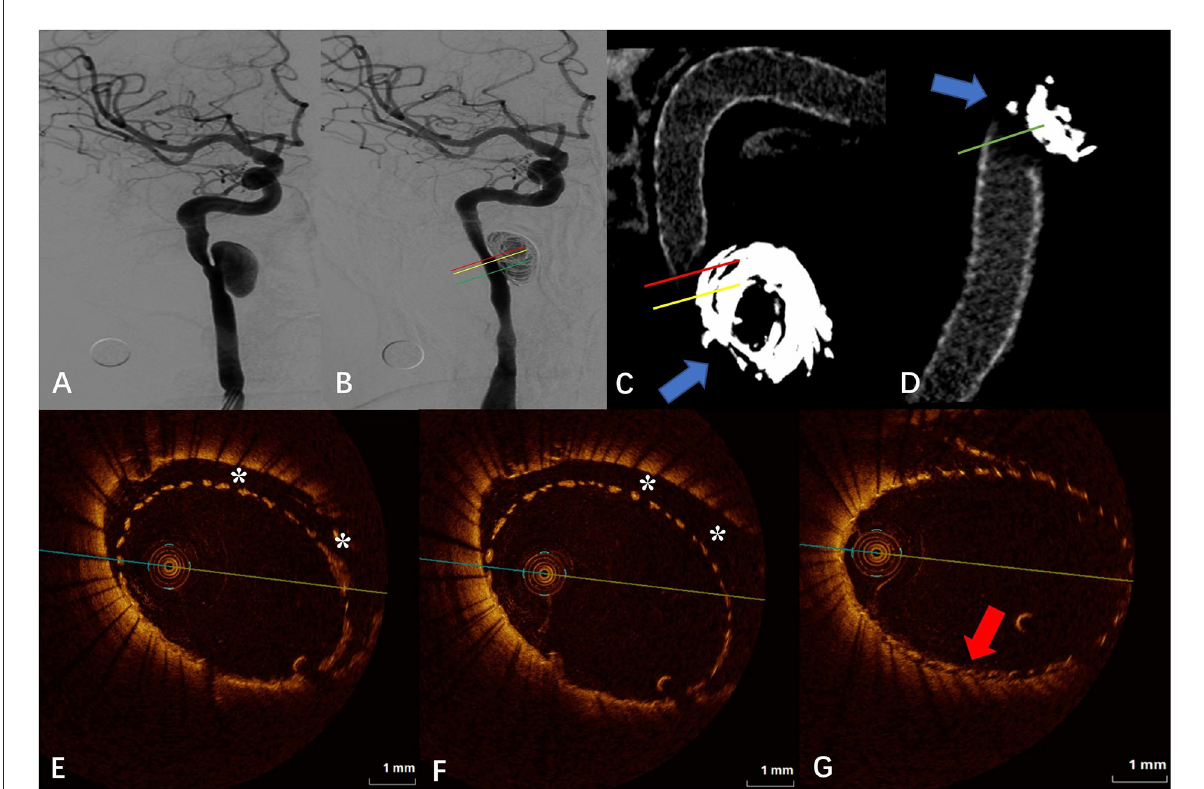
FIGURE1 (A) Digital subtraction angiography (DSA) before the flow-diverter placement. (B) Digital subtraction angiography (DSA) just after the flow-diverter placement. (C,D) Vaso CT images. Distal and proximal parent artery with good apposition of the FD to the wall. Artifacts near the aneurysm neck that disturb the evaluation of apposition by Vaso CT (blue arrows). (E,F) OCT images. The corresponding red (E) and yellow (F) line in (B,C) . Eccentric communication malapposition near the aneurysm (*). (G) OCT images. The corresponding green line in (B,D) . Good FD apposition at the aneurysm neck (red